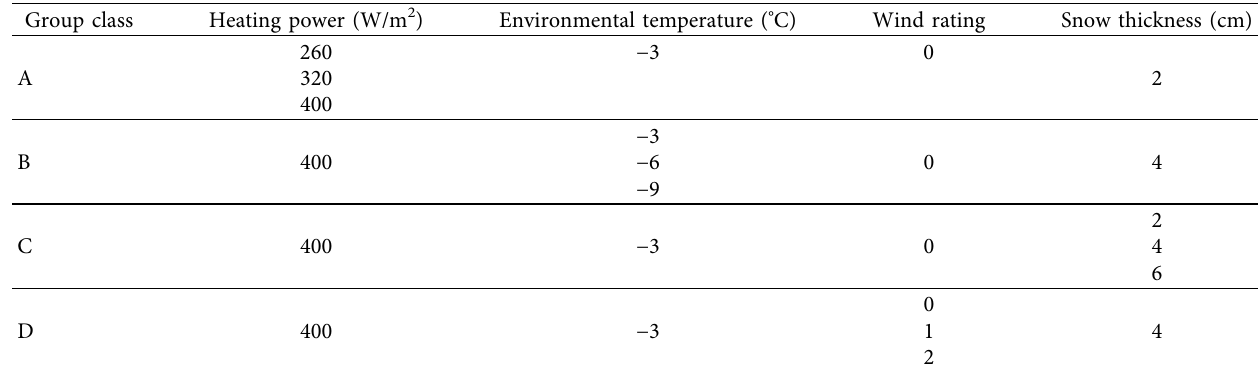
Table 4: Snow-melting test